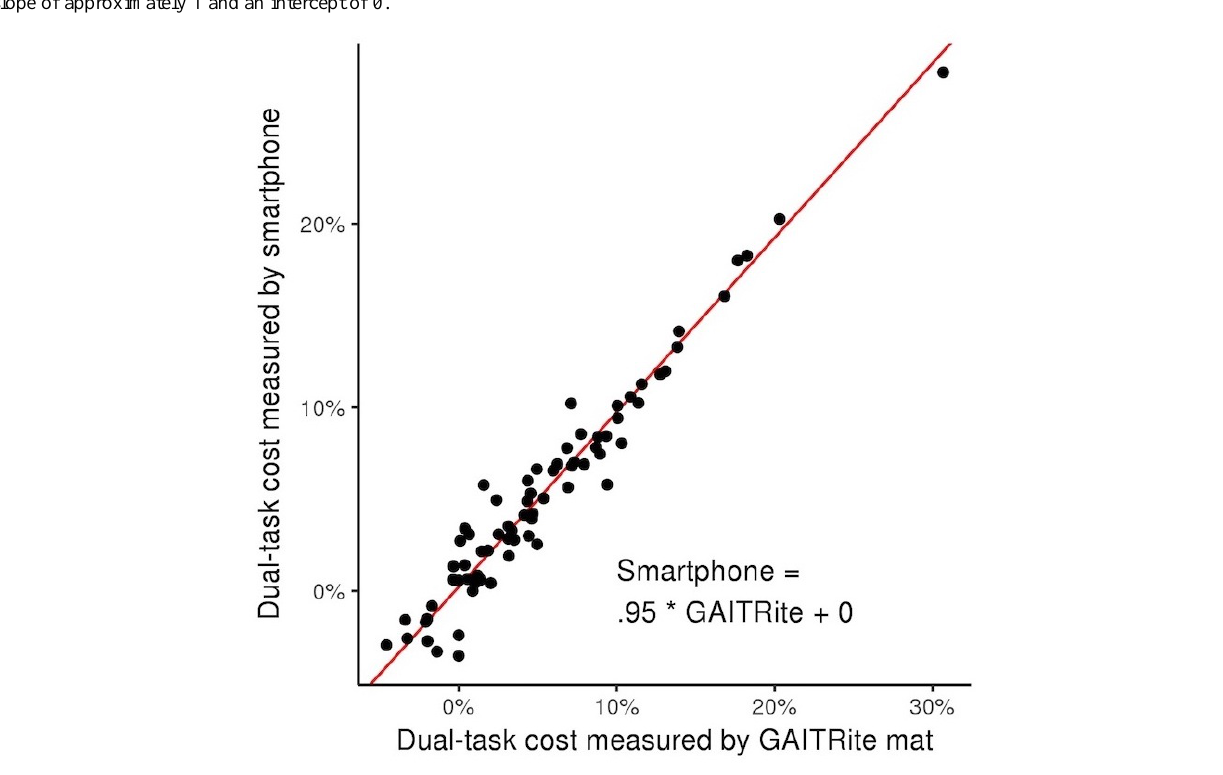
Figure 6. Relationship between dual-task costs to stride time as derived from a smartphone placed in the pocket and from a GAITRite mat. Dual-task cost was defined as the percentage change in average stride time derived from each pair of normal and dual-task walking trials. Dual-task costs as measured by the app and the GAITRite mat were strongly correlated with one another ( r 2 =.95, P <.001). The orthogonal best fit line of these data had a slope of approximately 1 and an intercept of 0.